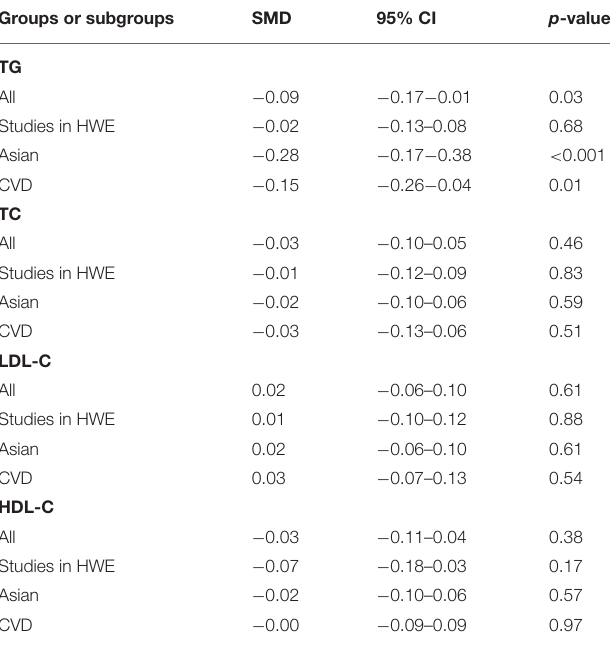
TABLE 4 | Meta-analysis of the miRNA-499a rs3746444 polymorphism with lipid levels (after excluding the study with heterogeneity). Groups or subgroups